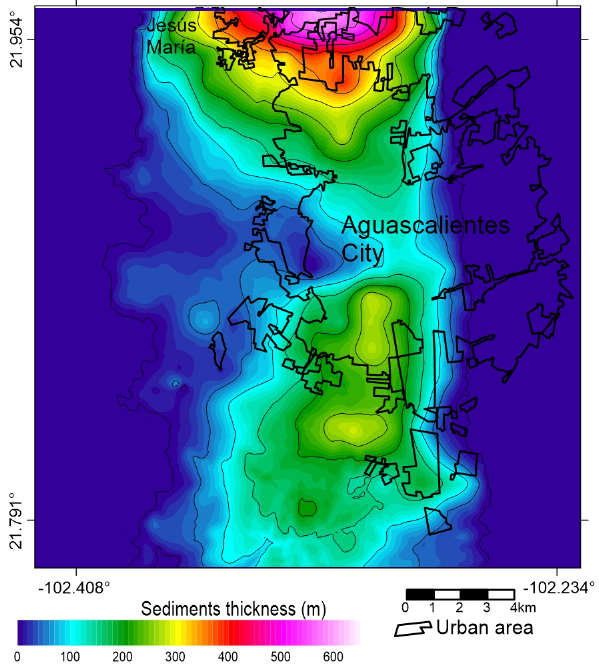
Figure 6. Map of sediments thickness in Aguascalientes